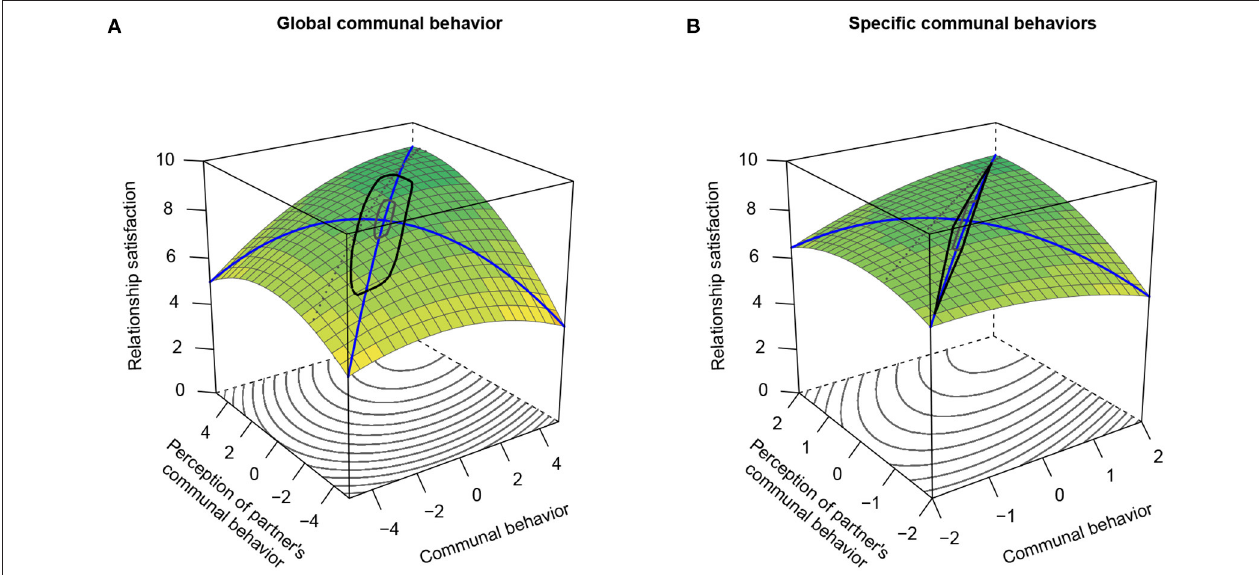
FIGURE 5 | Response surfaces for the prediction of momentary relationship satisfaction by individuals’ momentary communal behavior and perceptions of their partners’ momentary communal behavior. (A) Global communal behavior. (B) Specific communal behaviors. Figure available at: https://osf.io/2fz5w/ under a CC-BY4.0